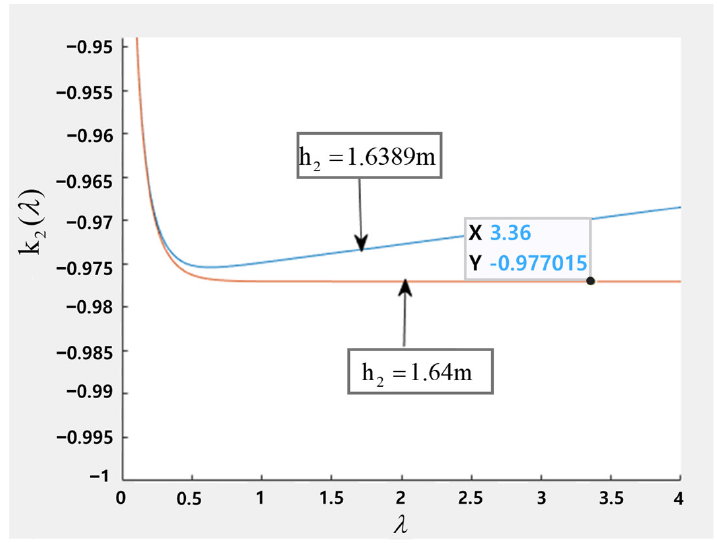
Figure 12.   (λ) according to the different ℎ  . Figure 12. k ( λ ) according to the different h 2